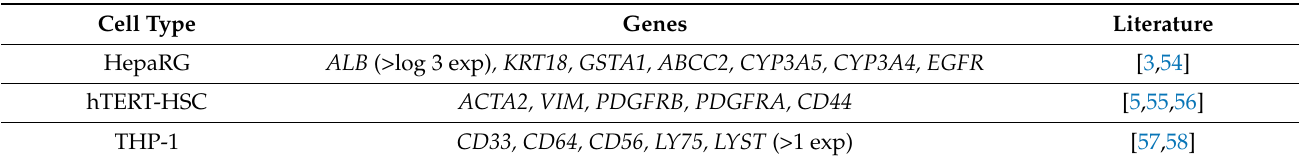
Table 4. Genes used for cell